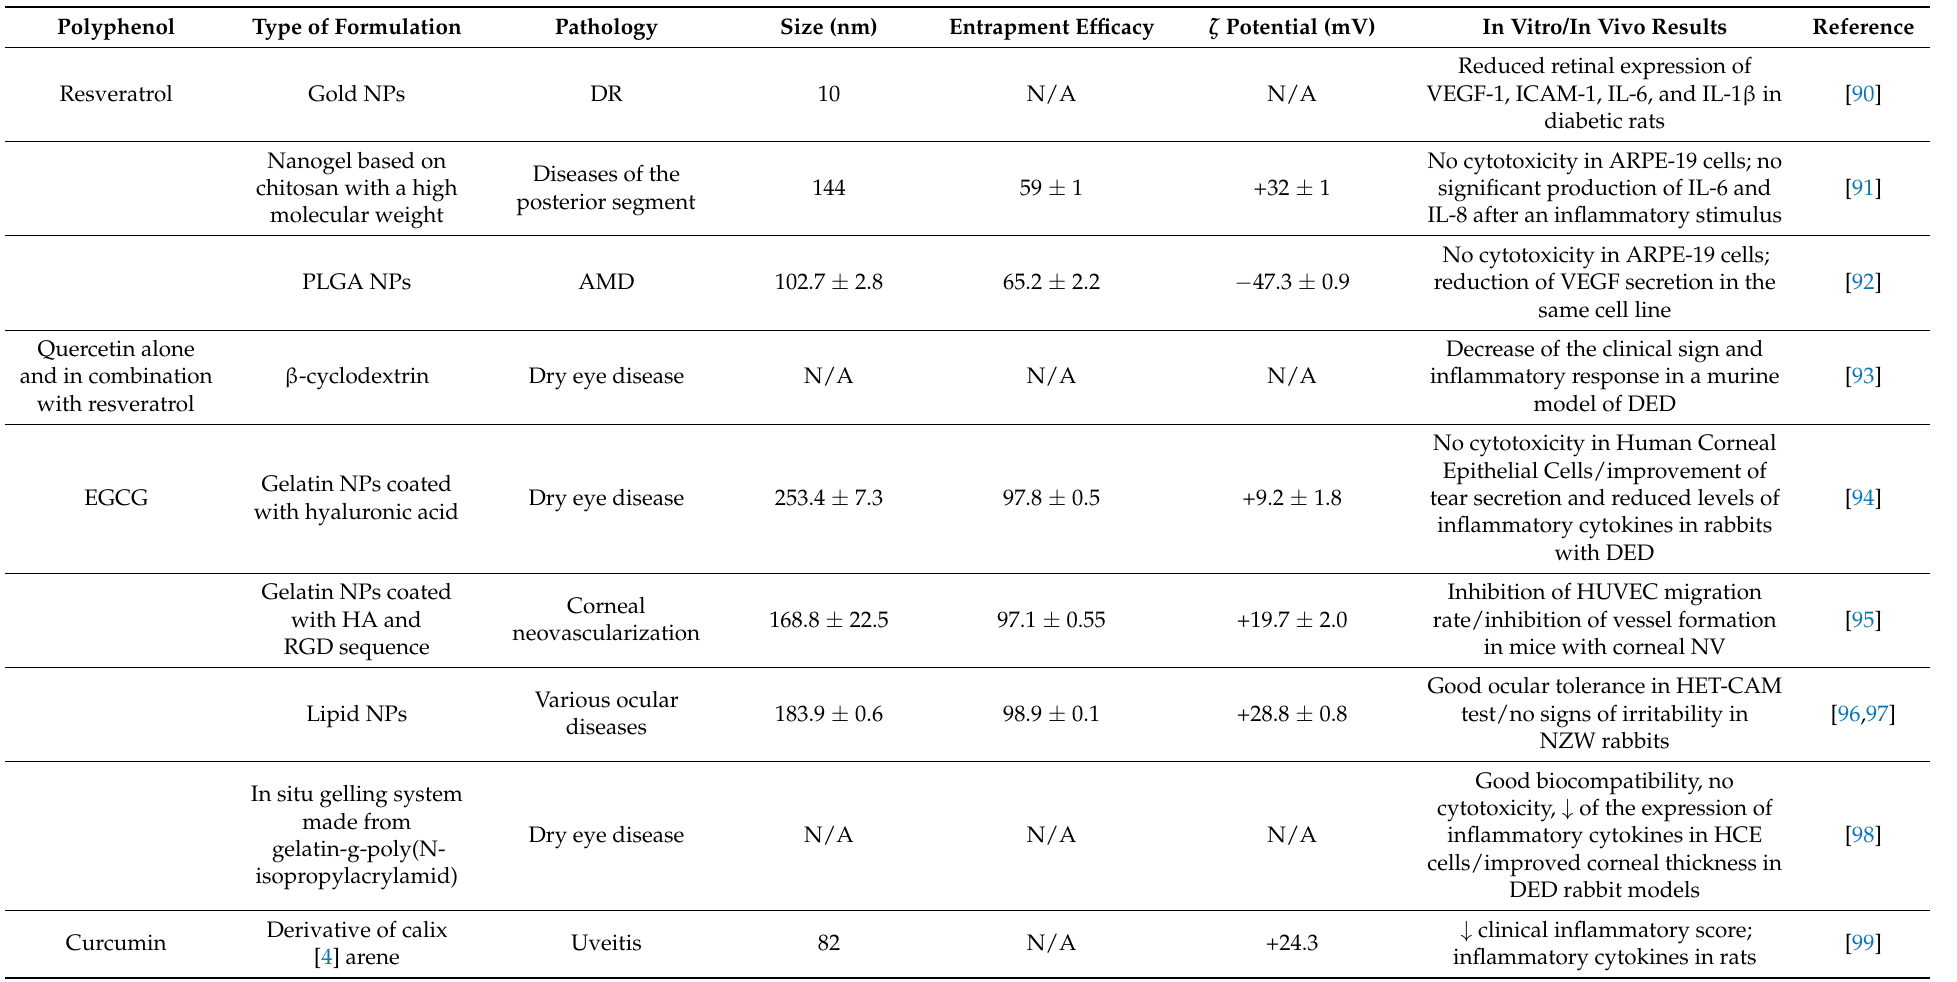
Table 1. Summary of different drug delivery systems that were used to deliver polyphenols to the